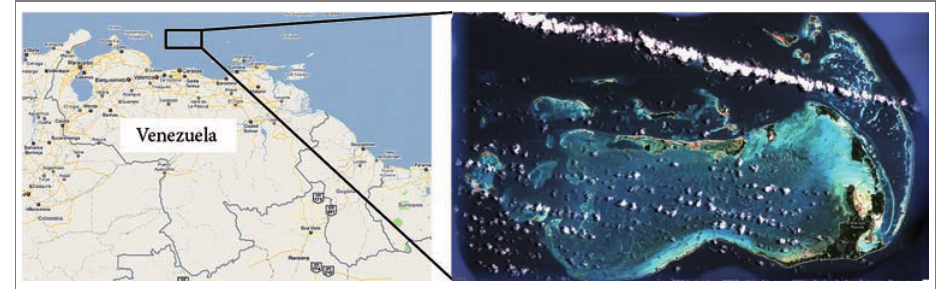
Fig. 2. Archipelago Los Roques National Park (obtained from Google